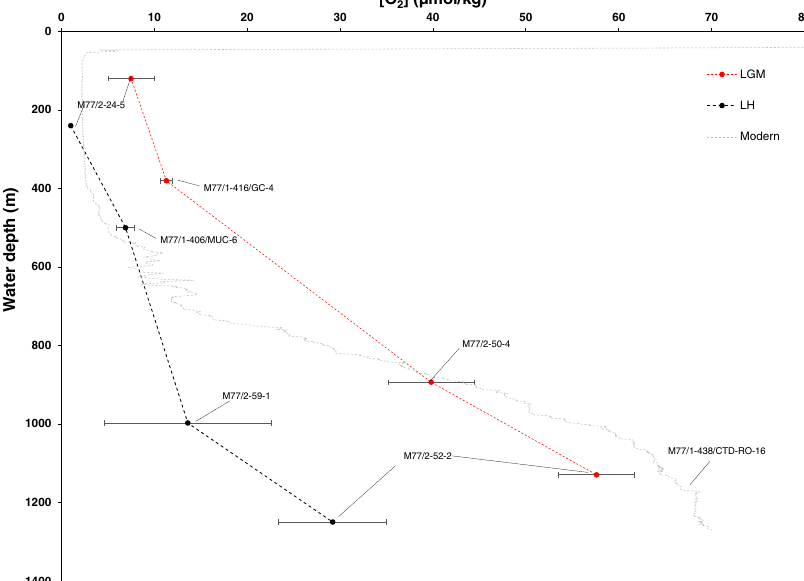
Fig. 6 Comparison of the Peruvian OMZ during the LGM, the LH and modern conditions. Bottom water O 2 concentrations ([O 2 ] BW ) reconstructed with different approaches for different depths at the Peruvian OMZ during the LGM (red) and the LH (Black). Data at 1000 – 1250 m are from Erdem et al. 14 , at ~500 m from this study and ~240 m from Scholz et al. 15 . Modern data are from 11°S M77/1-438/CTD-RO-16 57 . Note that water depths during the LGM have all been corrected by the lower sea level of ~120 m 47 . Datapoints for our data and Erdem et al. 14 are the weighted mean for each time slice and error bars are the standard error for the weighted mean. Scholz et al. 15 indicated a range of 5 – 10 µ mol/kg for the LGM (shown here as 7.5 ± 2.5 µ mol/kg). The data for the LH from Scholz et al. 15 were calculated after their Fig. 1b and indicated always anoxic conditions (here shown as 1 µ mol/kg without error